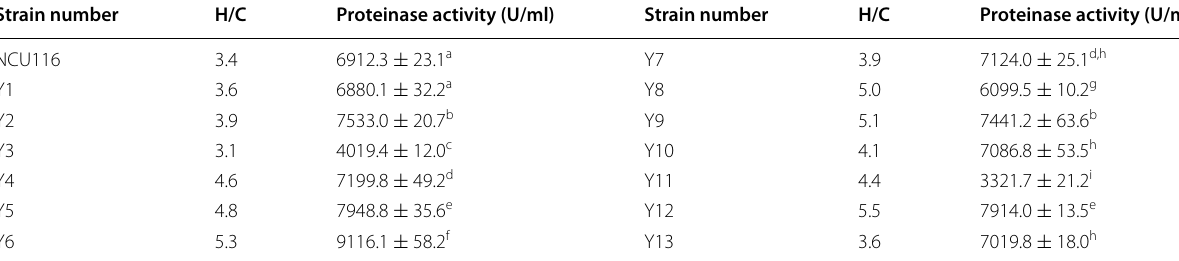
Y1–Y13 indicates that different strains obtained by mutagenesis. Values represent the mean a–i Significant difference at p < 0.05